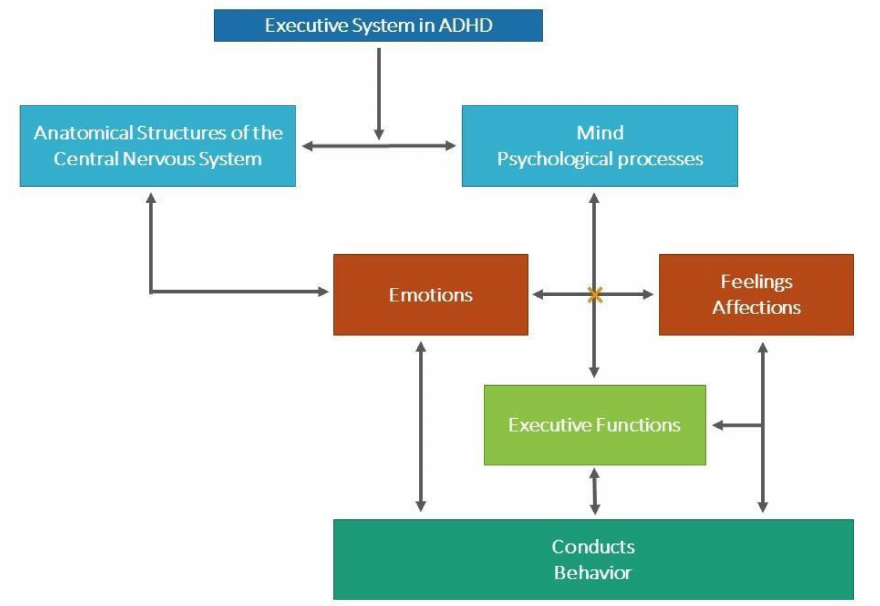
Figure 1. Proposal for an integrative cognitive-emotional conception of ADHD. ES: planning complex responses, programming the necessary actions to carry them out, monitoring their implementa- tion, controlling the interference of irrelevant stimuli, and correcting errors or incorporating new responses according to the demands of the environment [70]. CNS: areas of the Frontal Lobe and its connections with the Basal Ganglia, Limbic System, and Cerebellum. Psychological Processes: Perception, Attention, Working Memory, Language Internalization, Theory of Mind, Analysis and Synthesis Processes, Motivation. Emotions: Joy, Sadness, Anger, Fear. Feelings/Affects: Thought Emotions. EF: Self-Control and Self-Regulation, Planning/Organization, Flexibility, Decision-Making, Metacognition. Behaviors. The bidirectional arrows are intended to signify the reciprocal influences that occur between the different structures, psychological processes, and behaviors involved, to the extent that one or the other takes place. × :